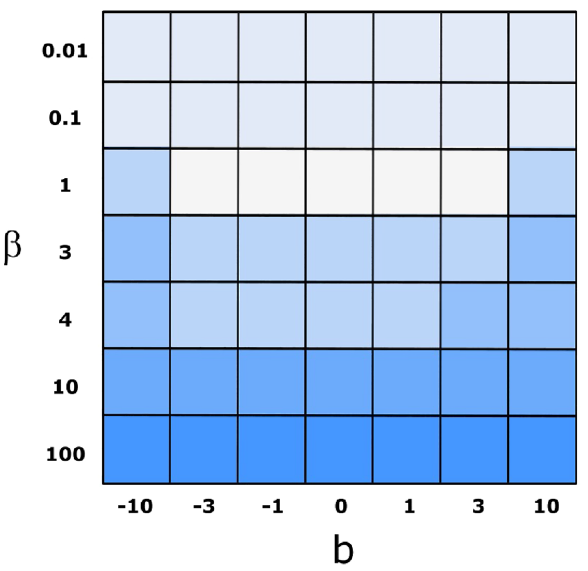
Figure 8. Graphical representation of the accuracy of Crooks’ fluctuation theorem for several pairs of parameters ( b , β) , which we measure through d b , β as explained in Sect. A.3.5. The color intensity grows monotonically with the distance d b , β and is divided into six regions, namely, d b , β ≤ 1 , 1 < d b , β ≤ 3 , 3 < d b ,